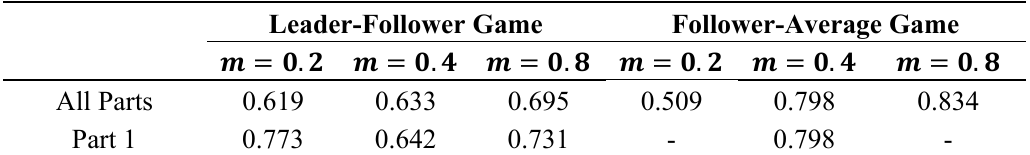
Table 4. Average cooperation factor of conditional cooperators for the six